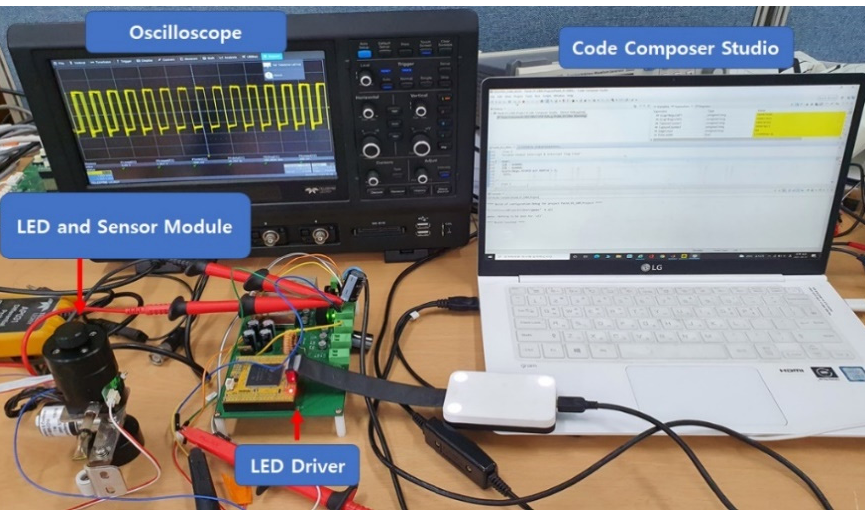
Figure 9. Experimental setup of the proposed TRO measurement system.